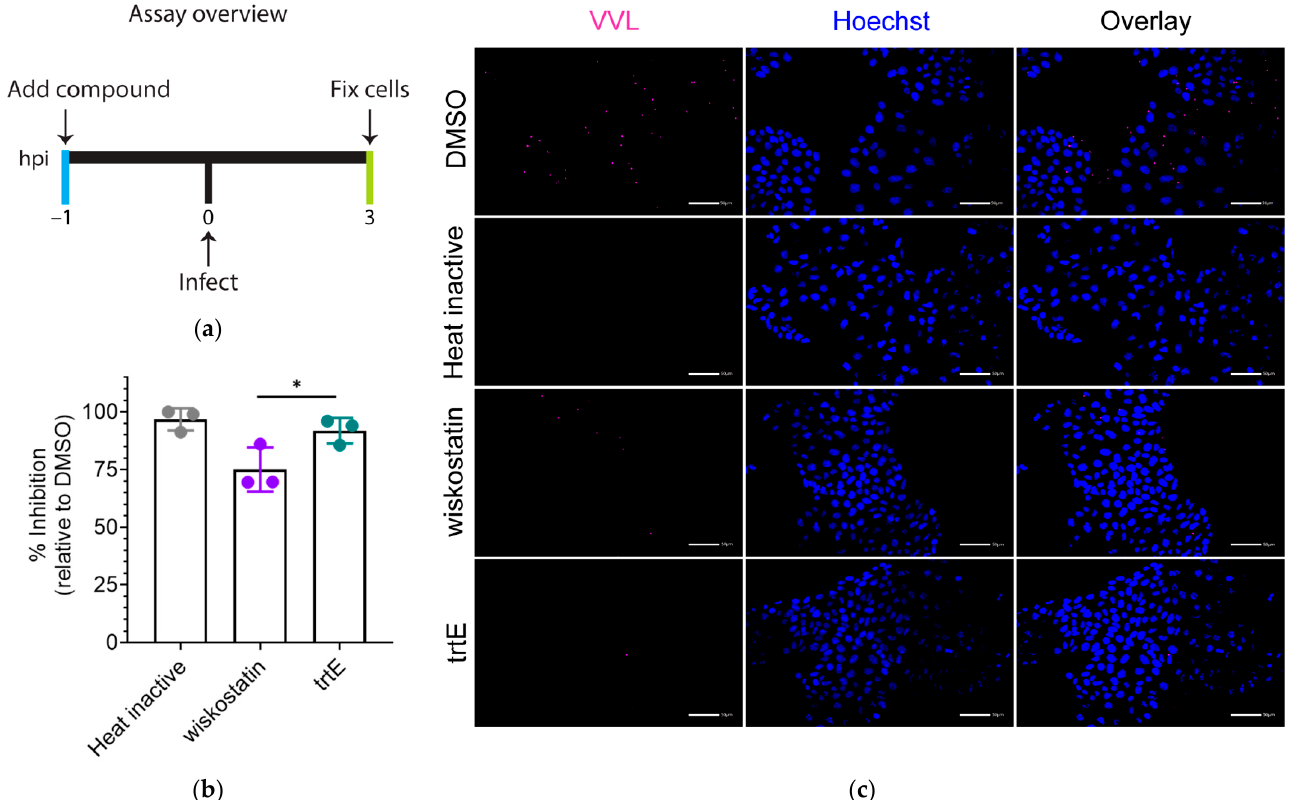
Figure 3. TrtE prevents establishment of C. parvum infection. ( a ) Overview of the invasion inhibition assay. ( b ) Quantification of parasite invasion. The graph shows percent inhibition of invasion relative to the DMSO control. Data shown are the mean ± SD of three independent